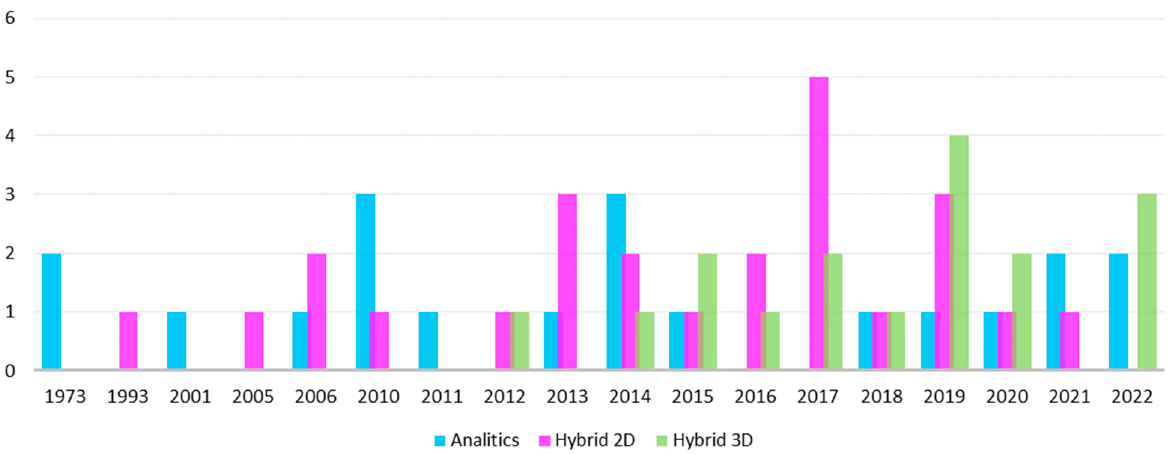
Figure 1. Number of publications on noise analysis methods of electric vehicles motors versus publication year.